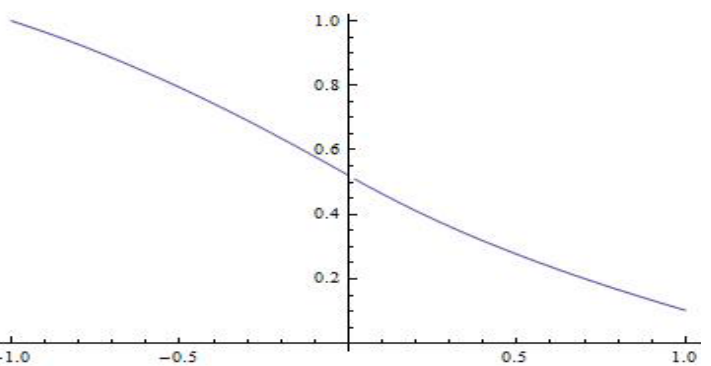
Figure 9. Graph of the eigenfuction corresponding to the eigenvalue λ 2 = 0.334608. (This graph was sketched by using “Mathematica 8”).